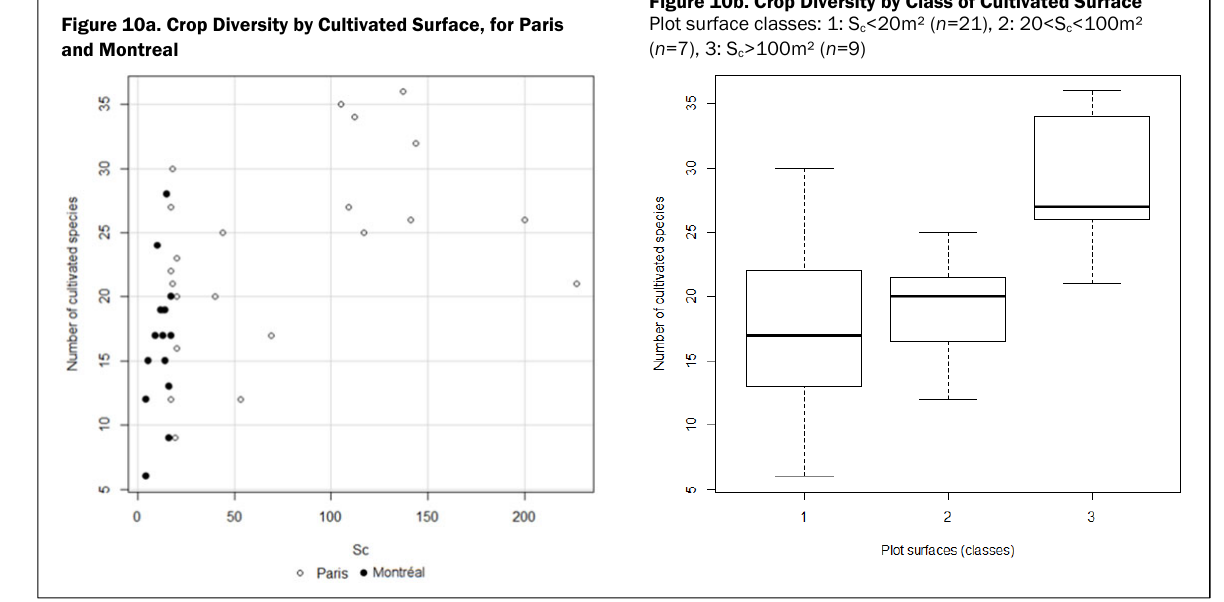
Figure 10b. Crop Diversity by Class of Cultivated Surface Plot surface classes: 1: S c <20m² ( n =21), 2: 20<S c <100m² ( n =7), 3: S c >100m² ( n =9)